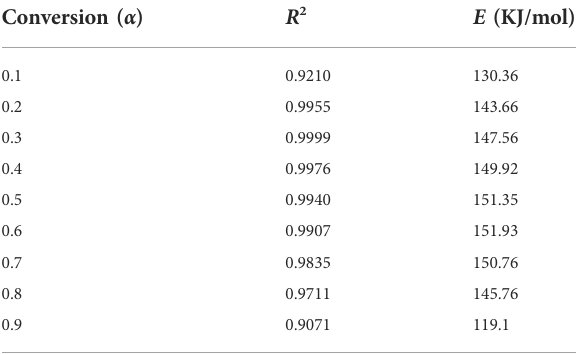
TABLE 3 KAS method to obtain activation energy and correlation coef fi